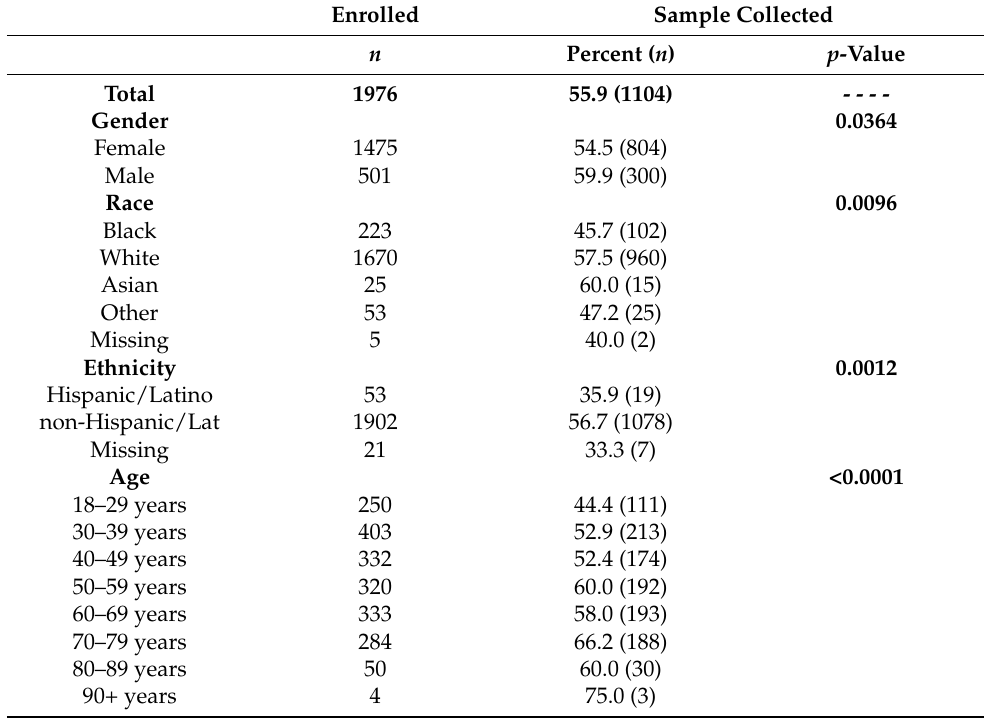
Table 4. Sociodemographic Characteristics of Samples